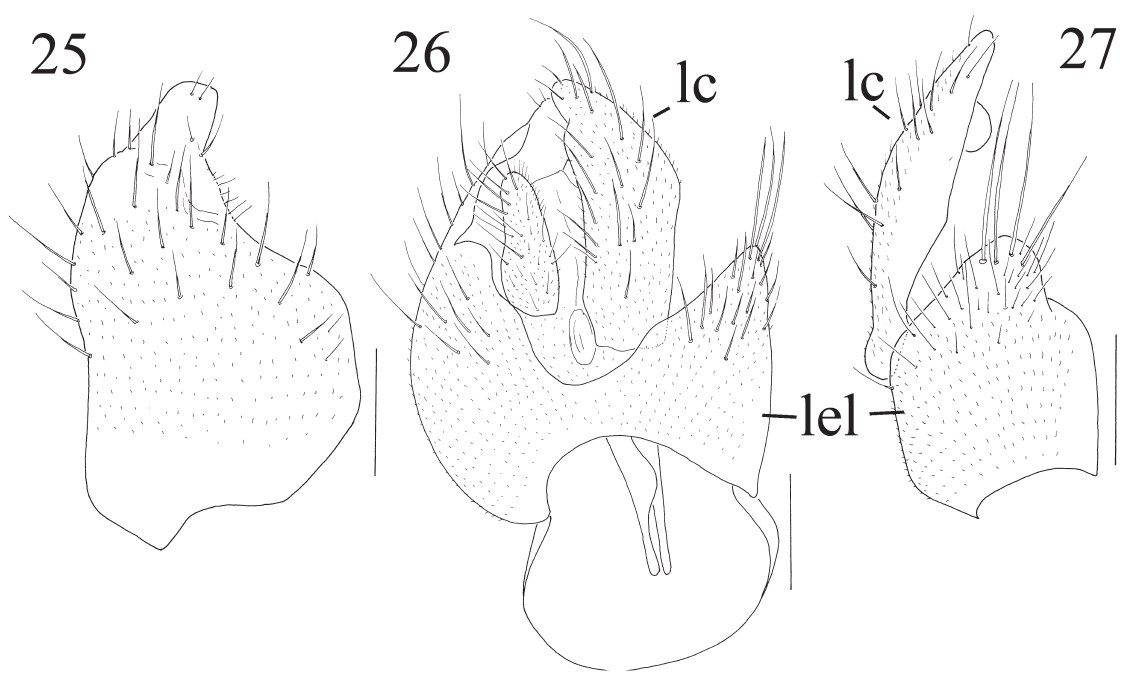
Figs 25–27. Platypalpus manjano sp. nov., holotype ♂. 25 . Right epandrial lamella. 26 . Epandrium with cerci, dorsal view. 27 . Left epandrial lamella. Scale bars = 0.1